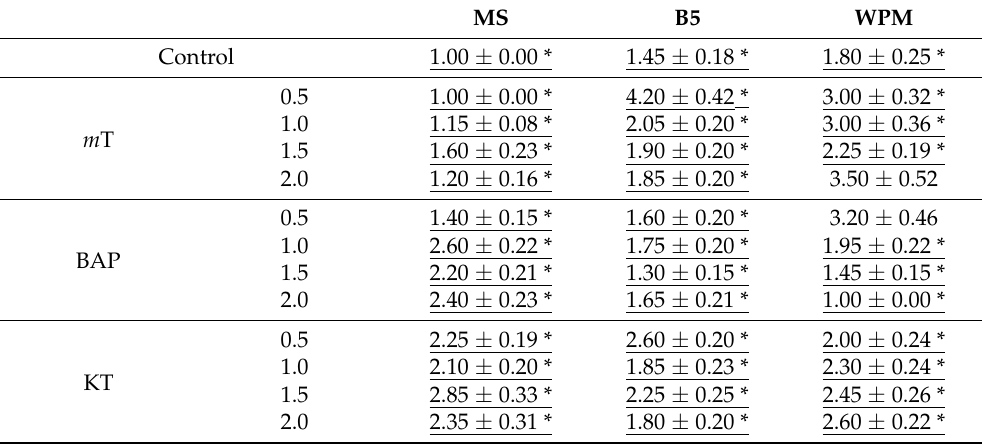
Table 3. Average values of H. cretaceus multiplication coefficient on different nutrient media.